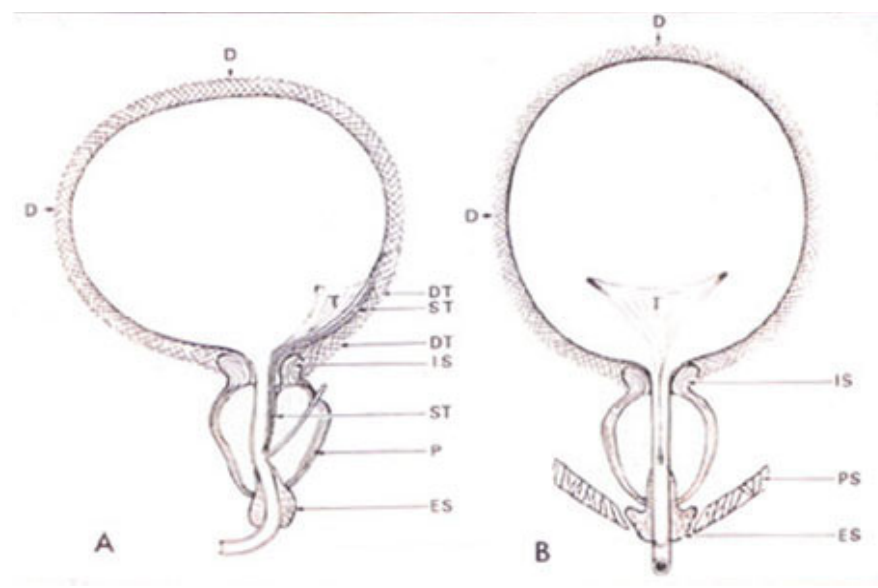
FIGURE 1. Gosling's interpretation of the male lower urinary tract. T, trigone; D, detrusor muscle; DT, deep trigone; ST, superficial trigone; IS, internal urethral sphincter; P, prostatic capsule; PS, external intrinsic striated urethral sphincter; PS, periurethral striated muscle. (Borrowed with permission from Urology Clinic of North